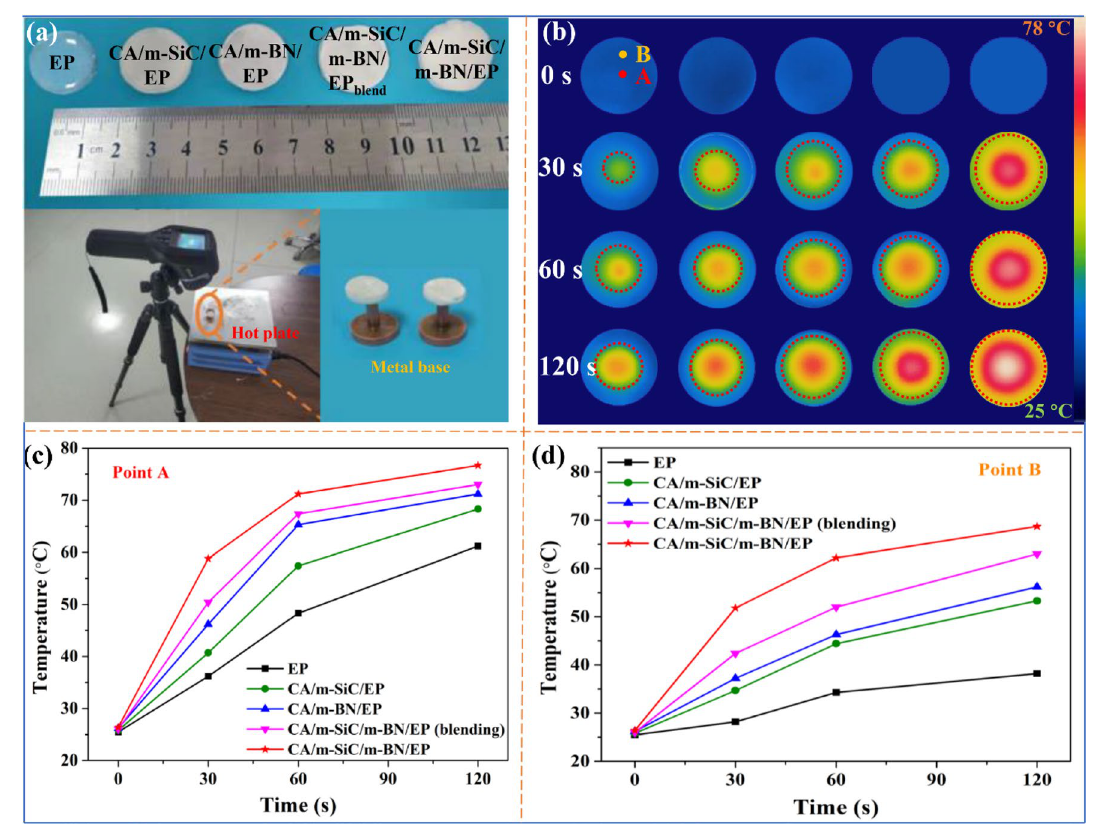
Fig. 7 a Optical photographs of different EP‑based composites and schematic design for thermal imaging test. b Infrared thermal images of dif‑ ferent EP‑based composites variation with heating time and c–d the temperature changes of A and B on the surface of EP‑based composites with heating